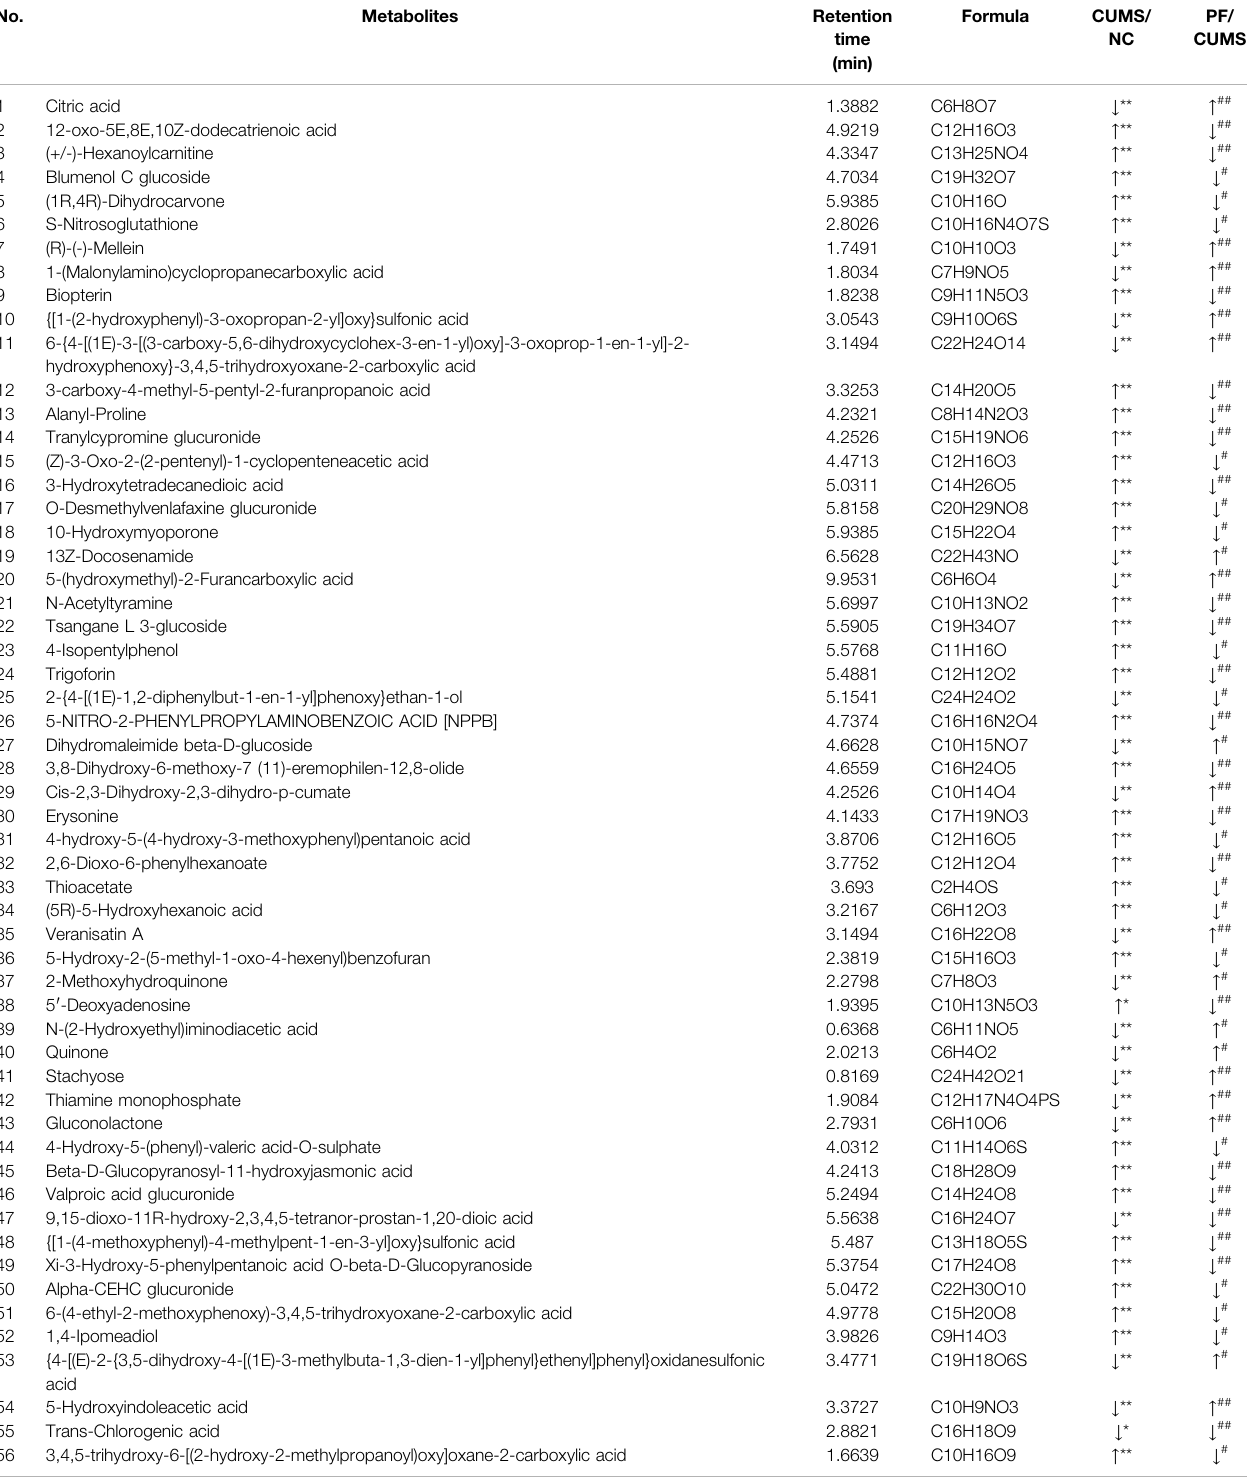
TABLE 2 | Different endogenous metabolites in rat